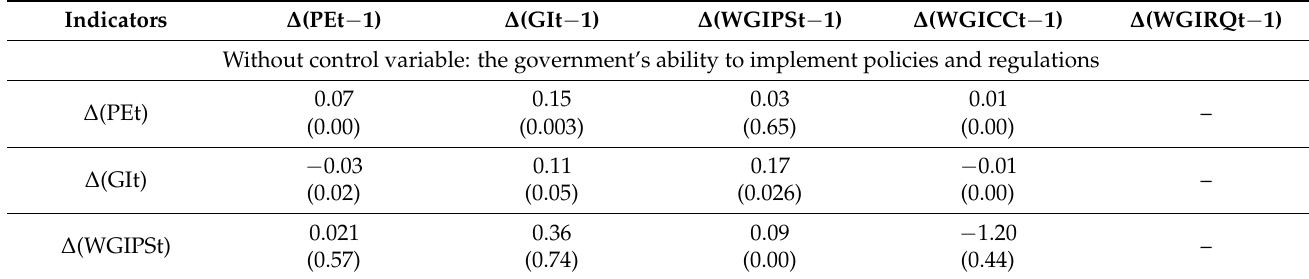
Table 6. The findings of the cointegration test among the energy efficiency gaps, green investment in the energy sector, the index of political stability, public perception of corruption for a short period, and the government’s ability to implement policies and regulations with a one-year lag for Ukraine in 2002–2019 (source: developed by the authors).